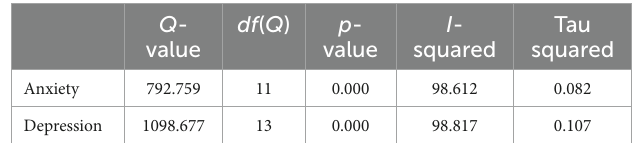
TABLE 4 Heterogeneity analysis.